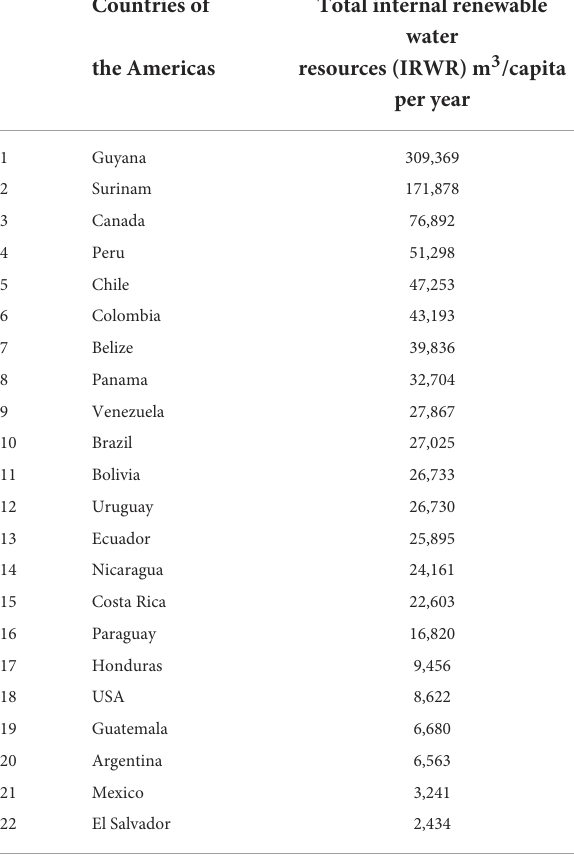
TABLE 2 Internal renewable water resources for countries of the Americas for 2018 [Food Agriculture Organization of the United Nations (FAO-AQUASTAT), 2022].